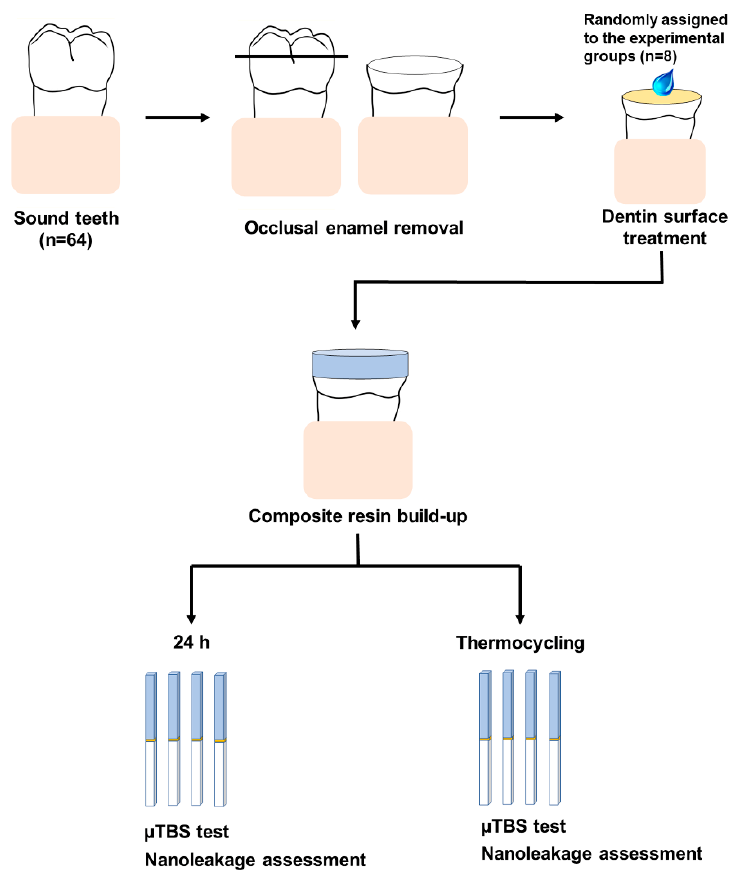
Figure 2. Schematic diagram illustrating the procedures for preparing the bonded specimens used in the microtensile bond strength and nanoleakage tests.